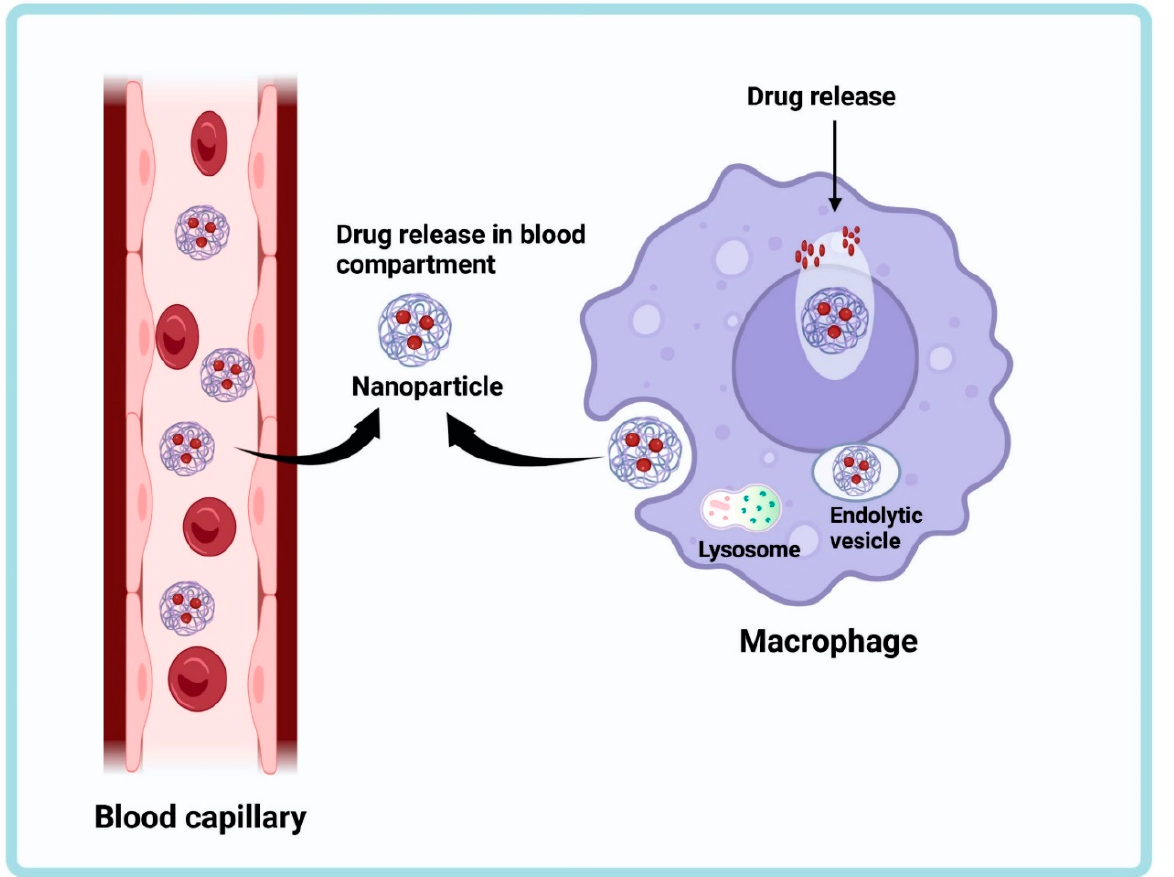
Figure 2. Mechanism of drug delivery by nanoparticles. The encapsulated drug release occurs in the infected macrophages. The drug is released in the blood compartment of the capillary. The nanoparticles from the blood capillary are engulfed by the infected macrophage, and the drug is released inside.